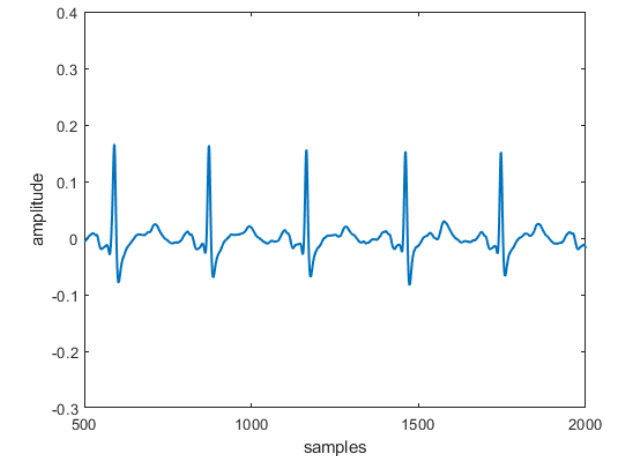
Figure 5. Case (a) of the proposed methodology: normal sinus